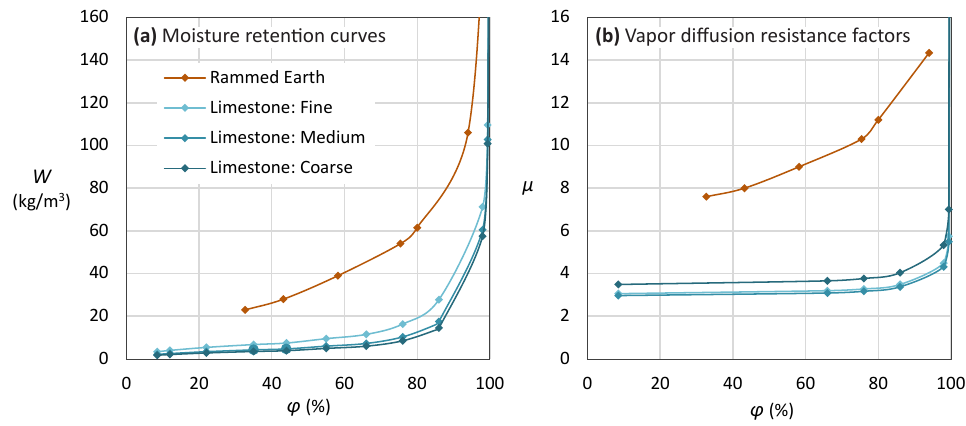
Figure 14. Rammed earth properties, as well as those of the three different Apulian limestones discussed below, used in the estimation of intrinsic evaporative cooling behavior: ( a ) moisture retention curves W and ( b ) vapor diffusion resistance factors µ . Rammed earth properties follow [51–53], with W obtained from (Allinson and Hall [51], Figure 4), and µ from Equation (8) using n = 29.5%. Limestone properties follow [54–56] with W for each sample obtained by scaling data for tuffeau limestone reported in [56] (Figure 7) using the estimated ratio of specific surface areas obtained using the pore size distributions for Apulian limestone reported by Andriani and Walsh [55] (Figure 8), and µ calculated from Equation (8) using n = 48%, 49%, and 44%, for the fine, medium, and coarse limestones,